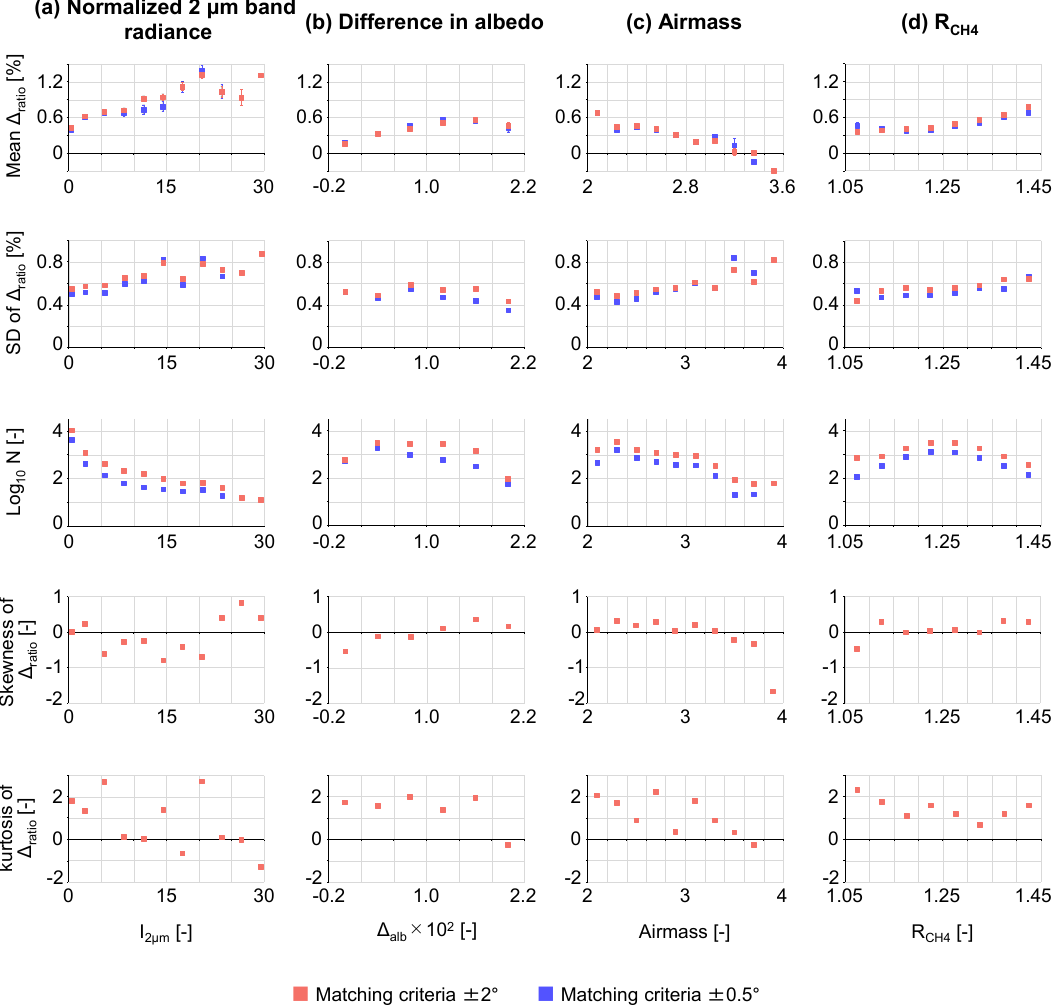
Figure A3. Relationship between the relative difference in the ratio component between GOSAT and TCCON ( Δ ratio ) and the related variables. The variables ( a – d ) are similar to those in Figure A2, but in each panel, the mean and standard deviation (SD) of Δ ratio , number of data points (N), skewness, and kurtosis for each bin are shown. Results for the different matching criteria are plotted (GOSAT data within ±2 ° and ±0.5 ° latitude/longitude boxes centered at each TCCON site). For I 2 μ m and R CH4 , the data with cloud fraction = 0 were used. For Δ alb and airmass, the data with cloud fraction = 0 and I 2 μ m ≤ 1 were used.